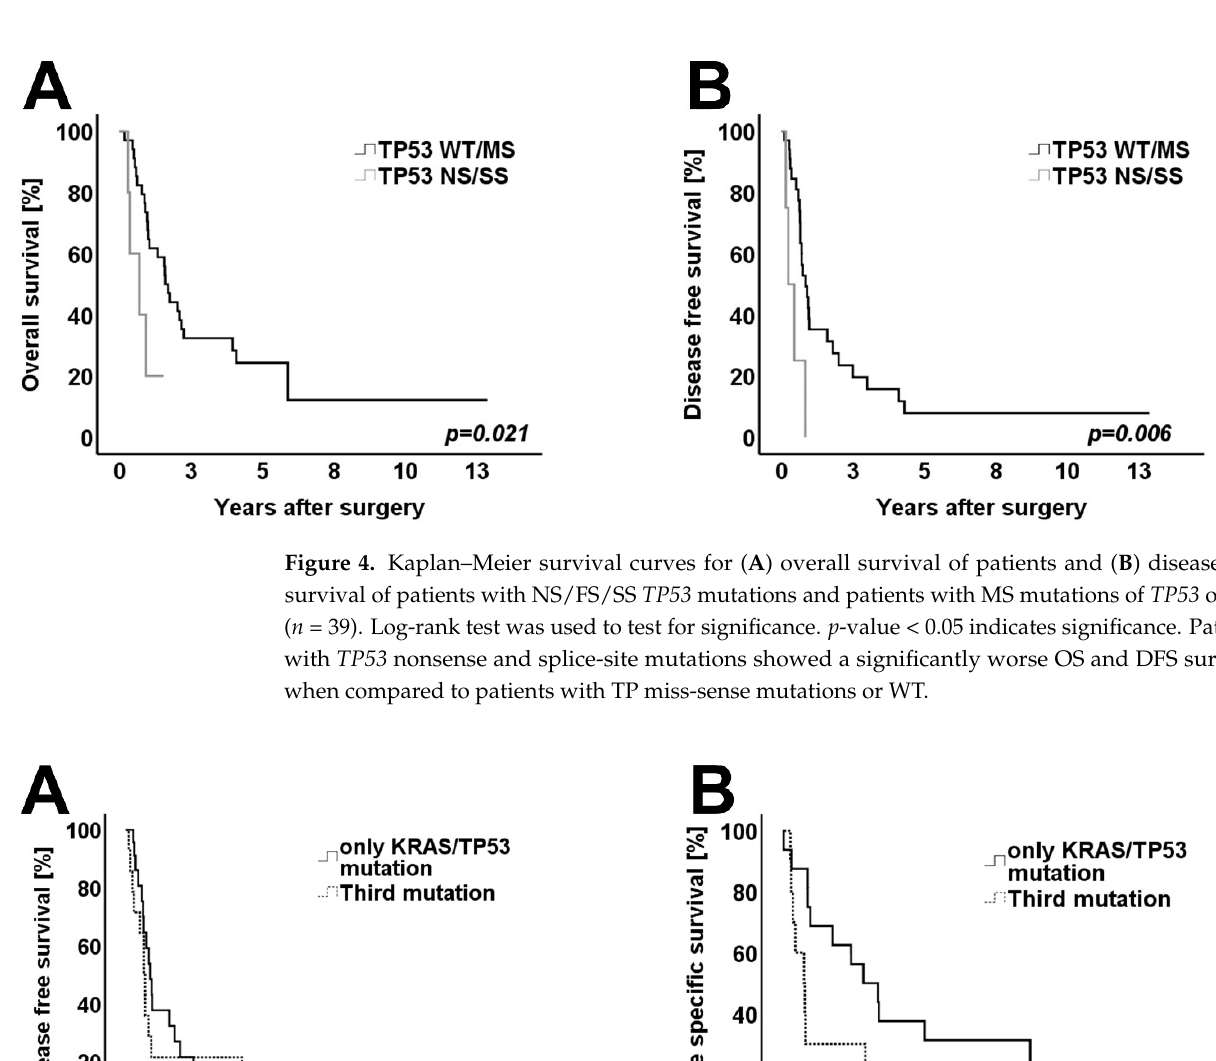
9 of 17 Figure 3. Kaplan–Meier survival curves for: ( A ) Overall survival of patients with a KRAS G12D mutation and patients with other KRAS mutations and WT ( n = 39). ( B ) Disease-free survival of patients with KRAS G12D mutation and patients with other KRAS mutation and WT ( n = 39). Log- rank test was used to test for significance. p -value < 0.05 indicates significance. Patients with KRAS G12D mutations showed a significantly worse OS and DFS when compared to patients with all other KRAS mutations or WT. The TP53 mutational status was subgrouped into TP53 nonsense and frameshift/splice-site mutations ( n = 5) vs. TP53 wild-type or TP53 missense mutations ( n = 34). Again, clinicopathological variables and histomorphology were distributed homog- enously between both groups. In the univariate analysis, patients with nonsense, frameshift/splice-site TP53 mutations showed a significantly worse OS and DFS when compared to patients with TP53 wild-type or TP53 missense mutations ( p = 0.021 for OS